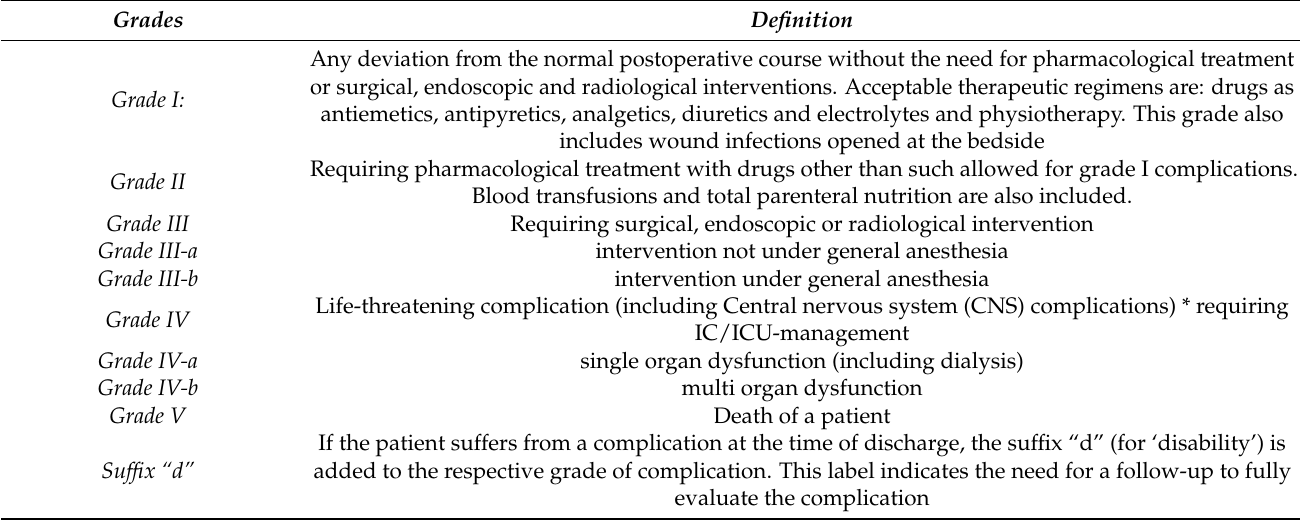
Table 1. Clavien Dindo postoperative complication scale (Dindo et al. 2004) .